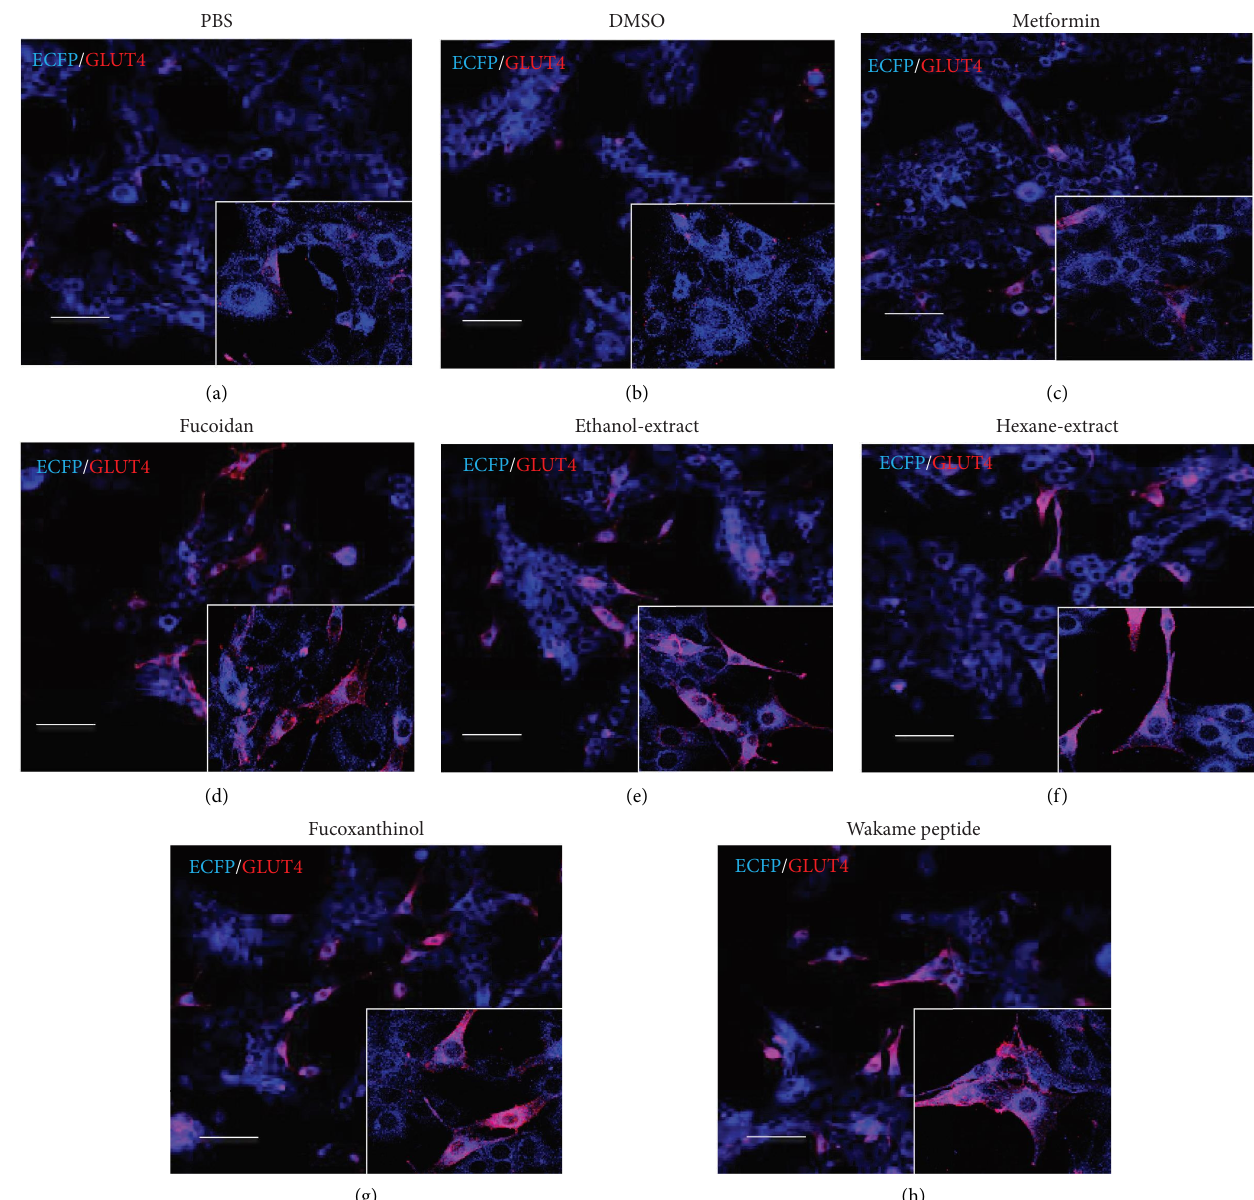
Figure 1: Efect of wakame components on GLUT4 membrane translocation in C2C12 cells. A representative image shows the translocated GLUT4 (red) and endogenous GLUT4 (blue). Myc-GLUT4-ECFP-expressing stable C2C12 (C2C12-G4) cells were treated with (a) PBS, (b) DMSO, (c) 1mM metformin, (d) 1mg/mL fucoidan, (e) 50 μ g/mL ethanol extract, (f) 50 μ g/mL hexane extract, (g) 1 μ g/mL fucoxanthinol, or (h) 100 μ g/mL wakame peptide for 20min. Te C2C12-G4 cells were then fxed with 4% PFA and stained with anti-Myc antibody followed by Alexa594-labeled secondary antibody. Scale bar, 50 μ